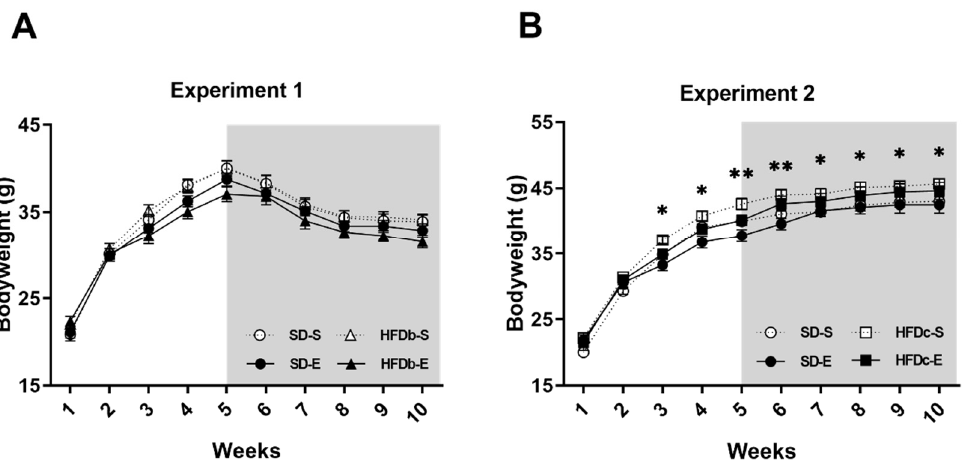
Figure 1. Body weight of mice over the procedure. Mean ( ± SEM) amount measured animals’ body weight. ( A ) No differences in body weight between the standard diet (SD) and high-fat diet binge (HFDb) groups were detected; ( B ) Significant differences between continuous high-fat diet (HFDc) groups and SD groups. * p < 0.05; ** p < 0.01.